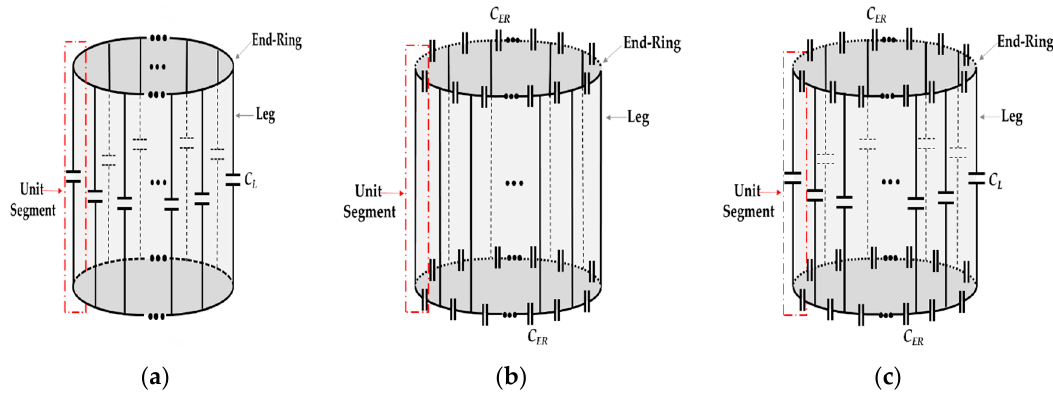
Figure 1. Schematic diagrams of the various types of the birdcage coil; ( a ) Low pass; ( b ) High pass; and, ( c ) Band pass.